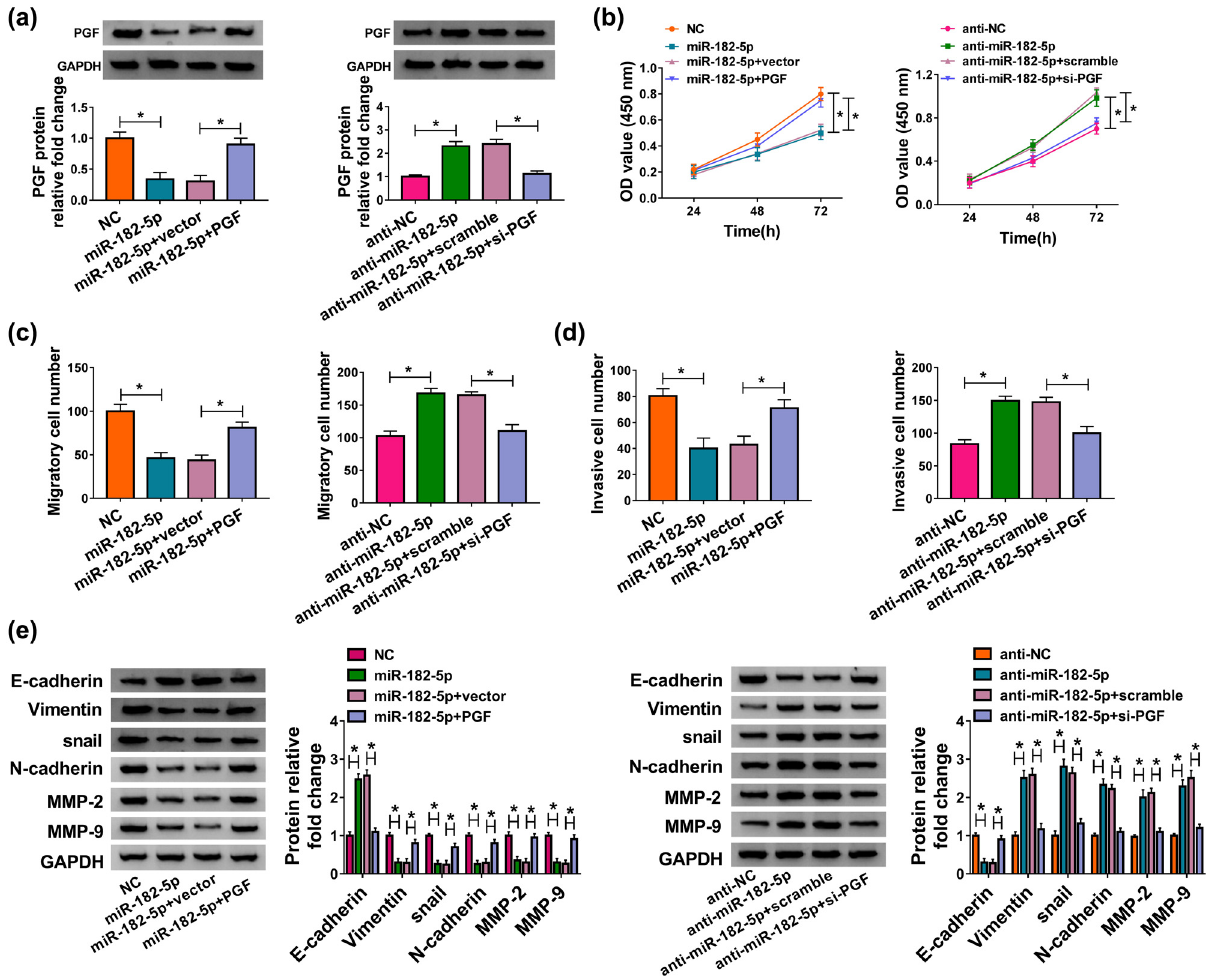
Figure 6: MiR - 182 - 5p regulated PE progression via targeting PGF. ( a ) The protein level of PGF in HTR - 8/SVneo cells transfected with miR - 182 - 5p, miR - 182 - 5p + PGF, anti - miR - 182 - 5p, and anti - miR - 182 - 5p + si - PGF was measured by western blot. ( b ) The CCK8 assay was conducted to check the proliferation of transfected HTR - 8/SVneo cells. ( c and d ) The transwell assay was executed to evaluate the abilities of cell migration and invasion. ( e ) The protein levels of EMT - related proteins were determined by western blot. * P <